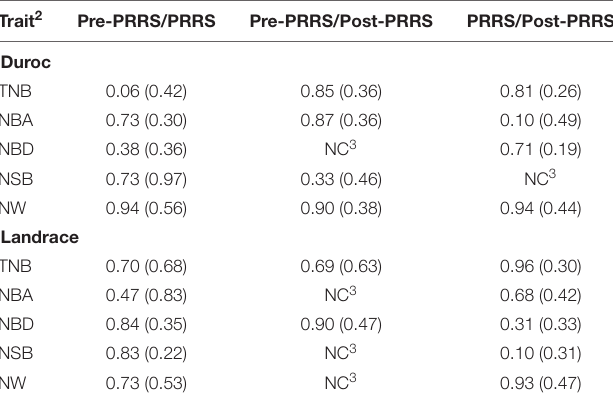
TABLE 6 | Estimates of genetic correlations (SE) of reproductive traits between PRRS 1 phases by